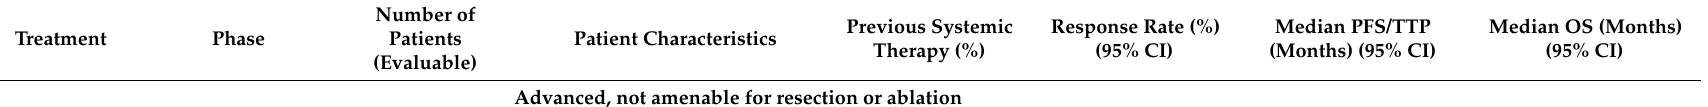
Table 2. Efficacy of checkpoint inhibitors in hepatocellular